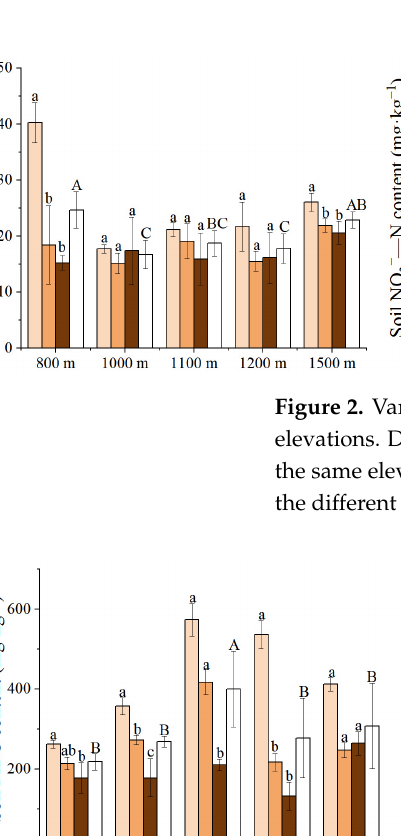
Figure 3. Variation characteristics of the soil’s MBC, MBN contents and MBC/MBN at different ele- vations. Different lowercase letters indicate significant differences between different soil layers at the same elevation gradient ( p < 0.05). Different capital letters indicate significant differences along different elevation gradients ( p < 0.05).